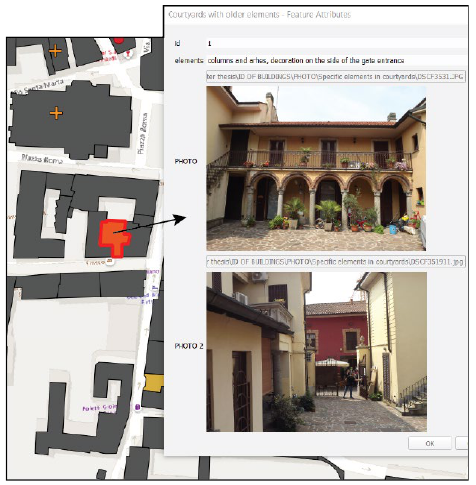
Figure 13. “Traces of the past” stored in the attribute table. Elements remained from the past in the present constructions. Source: